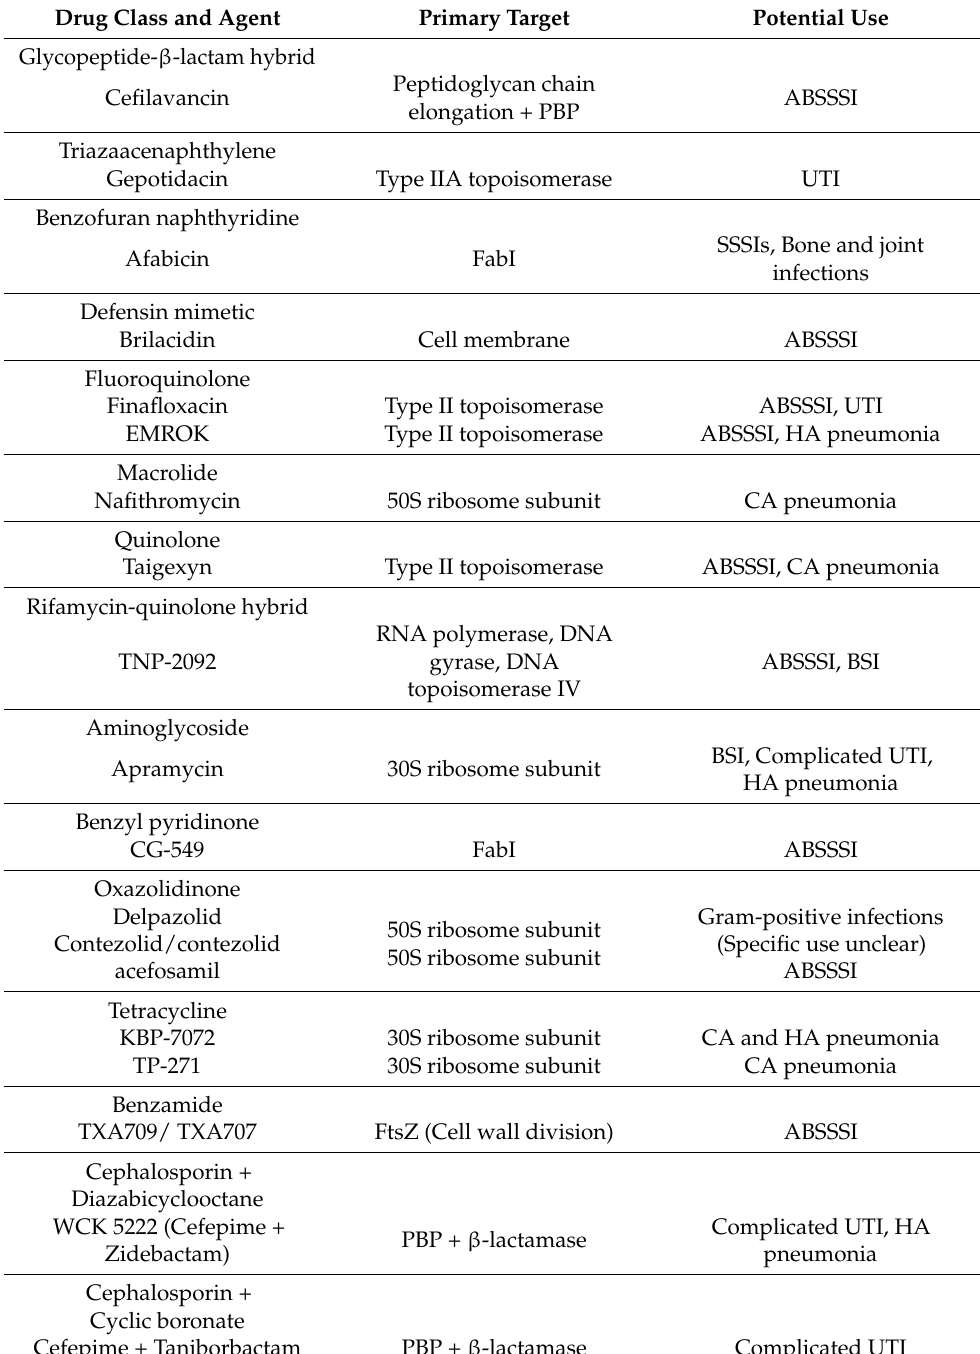
Table 1. Antibiotics currently in global clinical development with expected activity against Ente- rococcus faecium , Staphylococcus aureus , Klebsiella pneumoniae , Acinetobacter baumannii , Pseudomonas aeruginosa and Enterobacter species (ESKAPE) pathogens. Antibiotics with potential use to treat S. aureus infections are shown